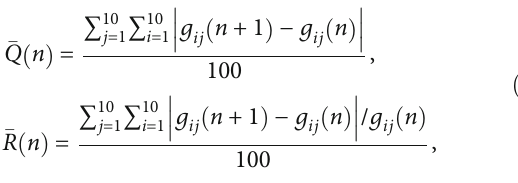
neurons fi re at about 30Hz (a) while DLM IN neuron is stimulated with the DC of 15 mA. However, DLM X and send them to PN